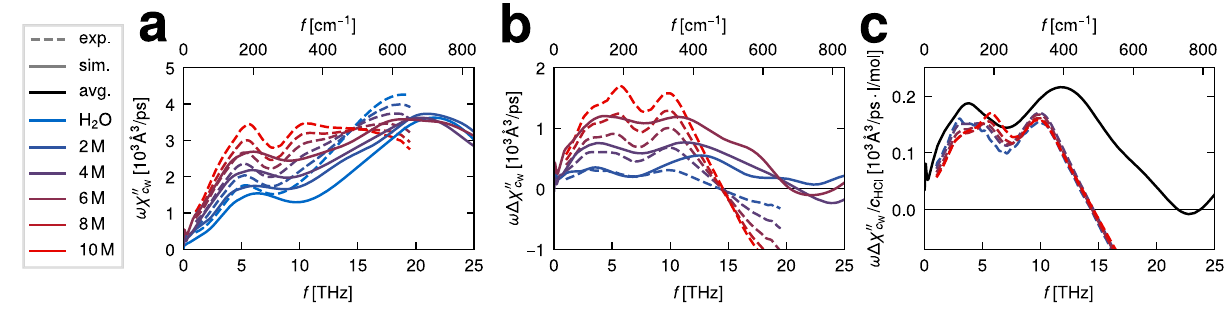
Fig. 2 Experimental absorption spectra. a Experimental THz/Fourier-transform infrared (THz/FTIR) absorption spectra of HCl solutions at various concentrations (colored broken lines for 2 M to 10 M), compared to literature data of pure water 74 (blue broken line). The experimentally measured extinction spectra have been converted into energy absorption spectra using the Kramers – Kronig relation, no amplitude adjustment is used in the comparison with the ab initio spectra (solid lines). b Experimental and ab initio molecular dynamics (MD) difference spectra derived from the results given in a and plotted in the respective colors and line styles. c The experimental difference spectra (shown in b) are divided by the HCl concentration c HCl (colored broken lines) and compared to the average of the simulated difference spectra after dividing by c HCl (black solid